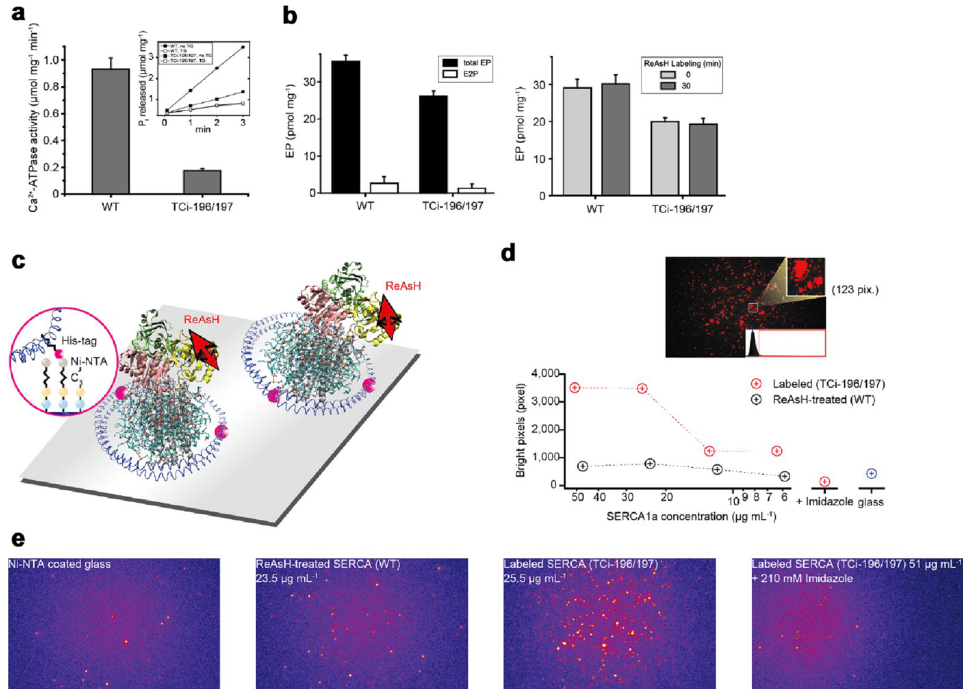
Figure 2. Ca 2+ -ATPase activity, amount of E P, and observation of ReAsH attached to the A-domain in SERCA1a molecule. ( a ) Ca 2+ -ATPase activity of expressed SERCA1a obtained by subtracting the ATPase activity determined in the presence of 1 μM TG as described under “Methods” section. The values presented are the mean ± SD (n = 3–4). Typical time courses of P i liberation in the wild type and TCi-196/197 mutant in the absence ( closed symbols ) and presence of TG ( open symbols ) are shown in the inset . ( b ) Total E P at steady- state and E 2P fraction. Microsomes expressing wild type or TCi-196/197 mutant were phosphorylated and E P was determined as described under “Methods” section ( Left ). There was no impairment of E P formation by ReAsH labeling ( Right ). Microsomes expressing wild type or TCi-196/197 mutant were labeled with ReAsH and E P was determined as described under “Methods” section. The values presented are the mean ± SD (n = 3–4). ( c ) ReAsH-labeled single SERCA1a molecule was stabilized on Ni–NTA coated glass surface via two his-tags incorporated into the membrane scaffold protein of the nanodisc. The angle of the nanodisc is not controlled because it has only two His-tags, not a three-point attachment. ( d ) SERCA1a concentration dependence of the number of observed bright pixels. To quantify the bright areas, mainly attributed to ReAsH, we calculated the area of bright pixels above the threshold value ( inset ). The number of bright pixels clearly depends on the concentration of the ReAsH-labeled SERCA1a embedded nanodisc (cf. Supplementary Fig. S2). ( e ) Fluorescent images of the glass surface (in the absence of protein), of the ReAsH-treated non-TC-tagged SERCA1a (WT), of the ReAsH-labeled SERCA1a (TCi-196/197) and of the imidazole-treated ReAsH-labeled SERCA1a (TCi- 196/197). Red dots represent fluorophores. Note that almost all SERCA1a embedded nanodiscs were detached with 210 mM